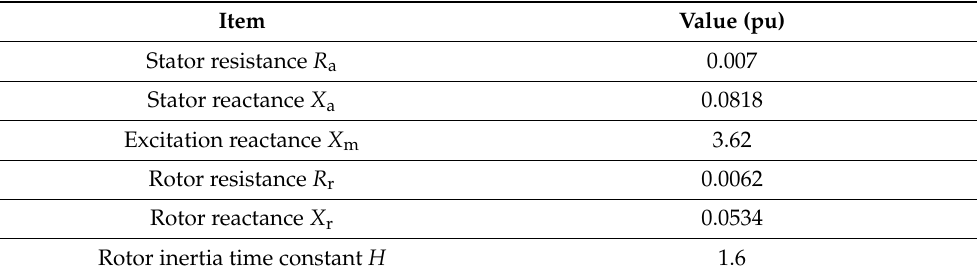
Table 3. Parameters of the induction